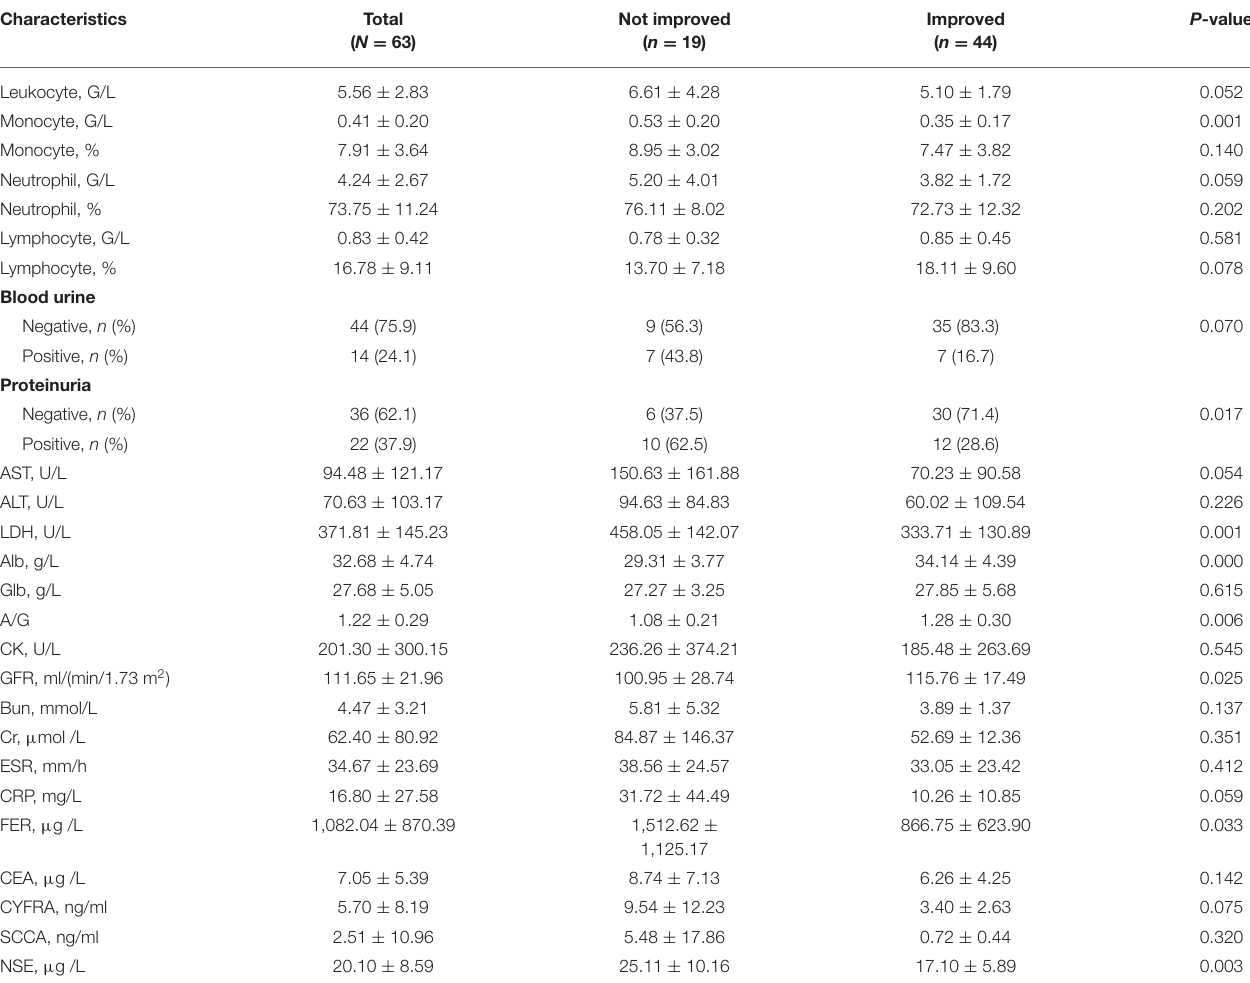
TABLE 3 | General laboratory tests for MDA5 + DM-ILD.